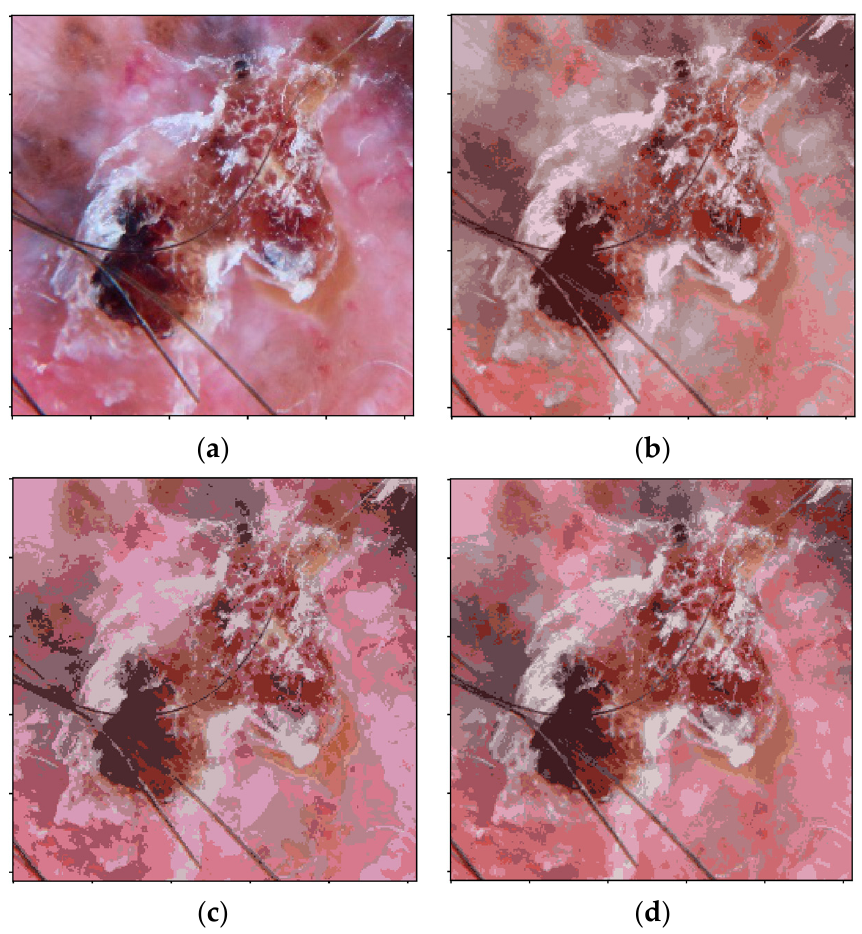
Figure 4. Color quantization in different color spaces. ( a ) Original image. ( b ) Image quantized in RGB color space (20 colors). ( c ) Image quantized in L*a*b* color space (18 colors). ( d ) Image quantized in CIECAM16-UCS (18